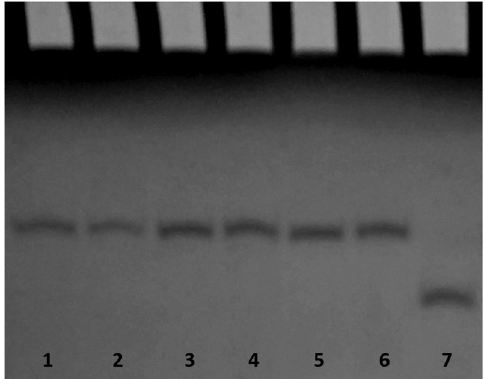
Figure 4. PAGE analysis of the natural and modified ODN sequences investigated. Lane 1: INTB - nat ; lane 2: INTB - H2 ; lane 3: INTB - H5 ; lane 4: INTB - H9 ; lane 5: INTB - H13 ; lane 6: INTB - H17 ; lane 7: TT - INTB - nat